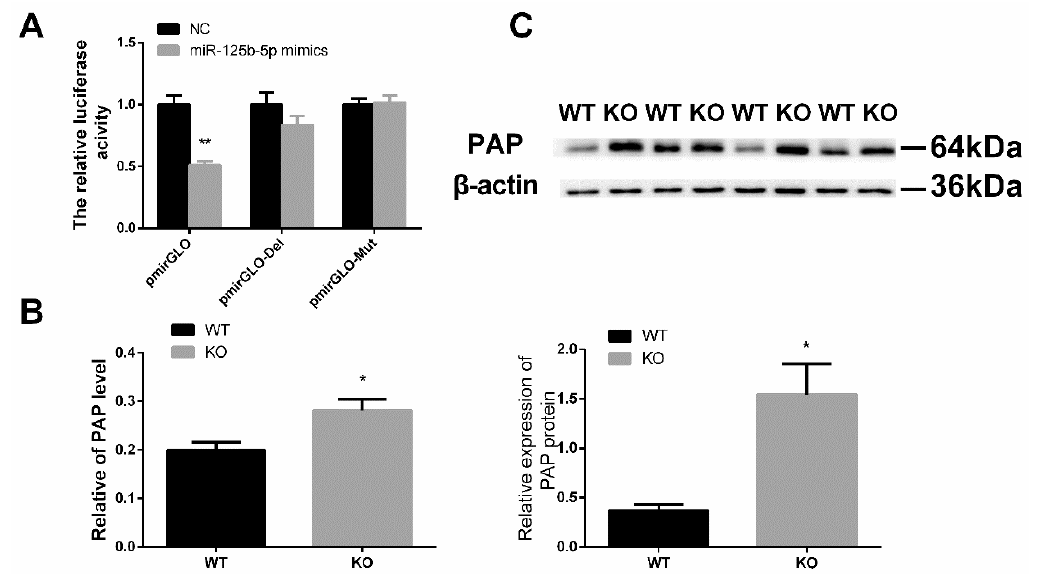
Figure 4. Papolb (PAP) is the target of miR-125b-5p. ( A ) PmirGLO dual-luciferase reporter vectors analysis ( n = 8). Relative luciferase activities were calculated by firefly luminescence/Renilla luminescence. ( B ) The PAP expression in mouse testis after knockout miR-125b-2 ( n = 8). ( C ) Characterization of the PAP protein and gray-scale scanning analyses in WT and KO mouse testis ( n = 4). Values are the mean ± SEM. * p < 0.05, ** p < 0.01.